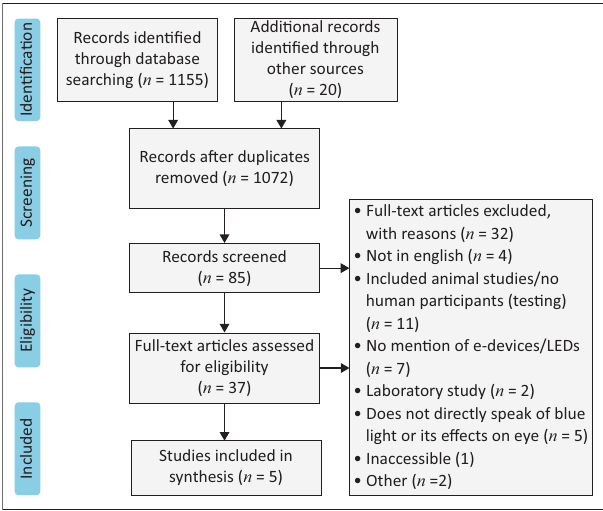
FIGURE 2: PRISMA flow diagram of study selection process. TABLE 1: Characteristics of included studies.